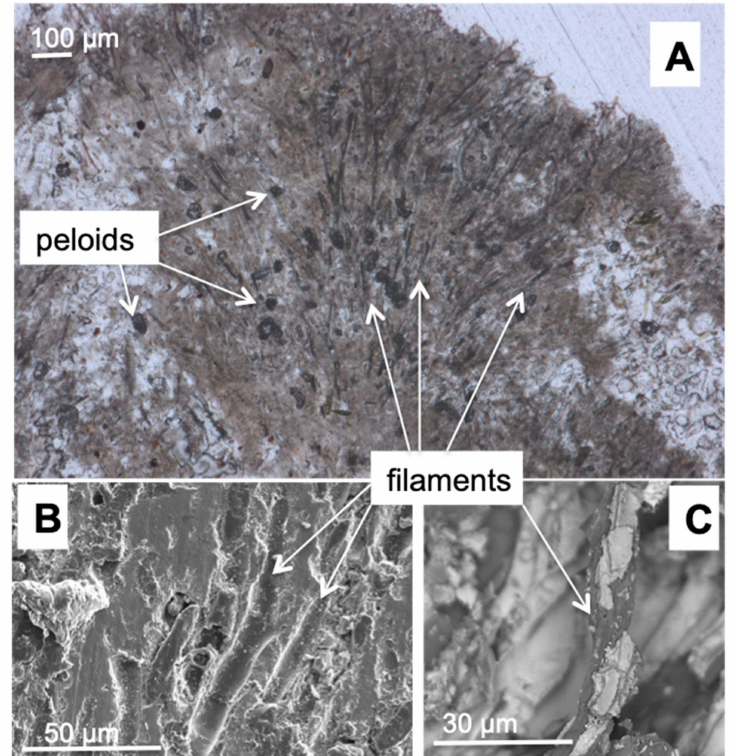
Figure 8. Natural samples observed ( A ) in thin section, showing micro-peloids and 10- µ m large, Phormidium -like filament encrusted in carbonate and ( B , C ) under SEM; ( B ) shows imprints of Phormidium -like filaments and ( C ) depicts the encrusting carbonate on the surface of the same filaments. Note the di ff erences in scale.